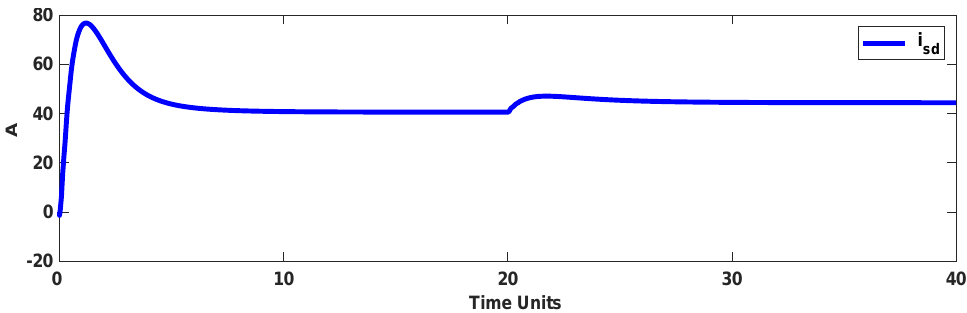
Figure 10. Rotor speed tracking error in the faulty condition.